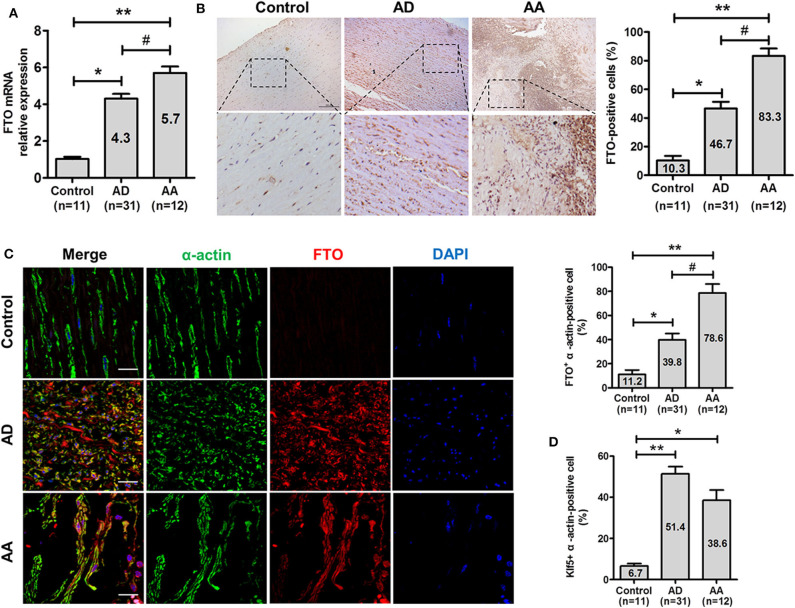
FTO is highly expressed in human aortic dissection (AD) and aortic aneurysm (AA). (A) qRT-PCR for FTO expression in human AD (n = 31), AA tissues (n = 12), and control (n = 11). **P < 0.01 vs. Control, #P < 0.05 vs. AD. (B) Representative photographs of immunohistochemical staining for FTO in human ADA tissues and control. Scale bar = 100 μm. Right: Statistics of FTO -positive cells in human ADA, RADA tissue, and control. *P < 0.05, **P < 0.01 vs. control, #P < 0.05 vs. ADA. (C) Confocal immunofluorescence for human ADA and control sections stained with α-actin, FTO, and 4′,6-diamidino-2-phenylindole (DAPI). Right: statistics of FTO+ α-actin–positive cells in human AD, AA tissues, and control. **P < 0.01 vs. Control, #P < 0.05 vs. ADA. (D) Statistics of Klf5+ α-actin–positive cells in human AD, AA tissues and control. All data were present mean ± SD, *P < 0.05 and **P < 0.01 vs. Control.